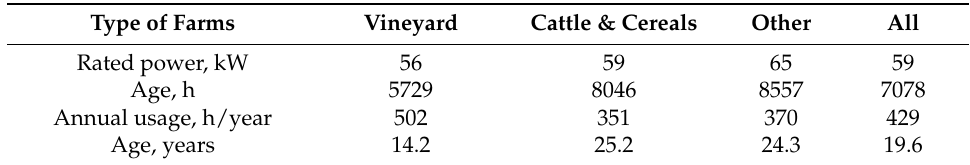
Table 8. Second survey: Tractors power, age and usage.